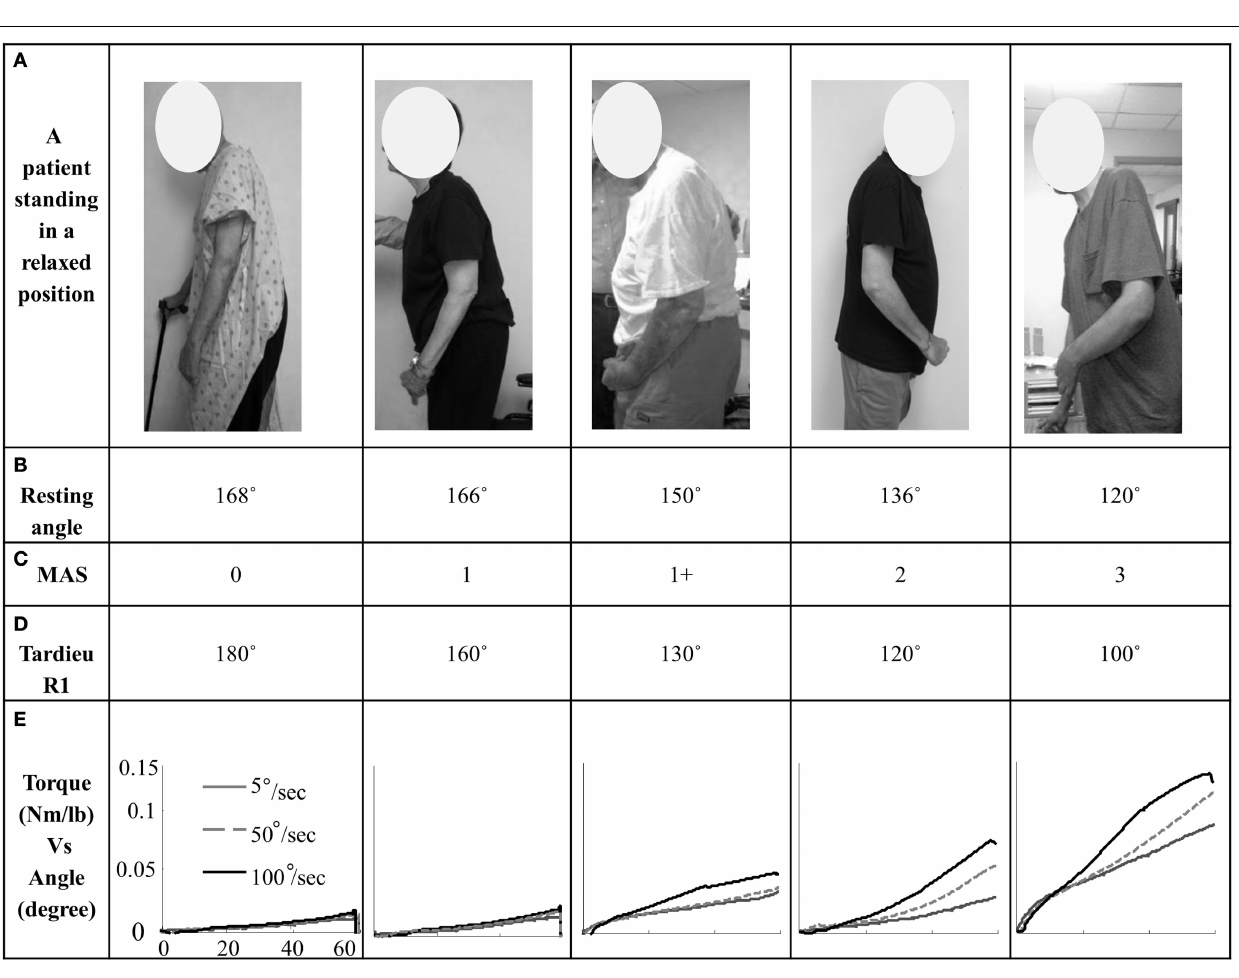
Frontiers in Neurology |